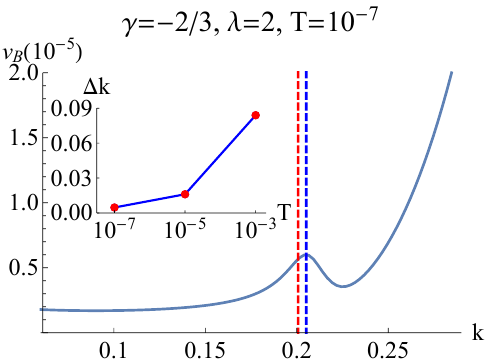
Figure 3 . The butterfly velocity v B as the function of k for γ = − 2 / 3 at T = 10 − 7 . The inset plot is for the temperature dependence of ∆ k , which is the difference between the position of QCP and the local maxima of v . The red dashed line is the position of QCP and the blue dashed line is the B local maxima of v . Here we fix λ = 2 B